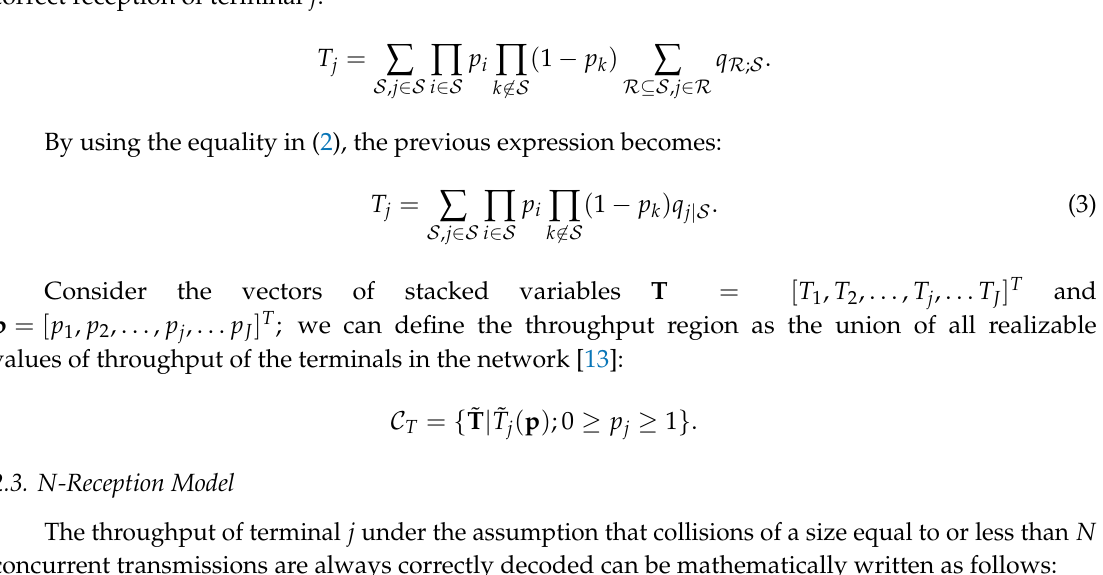
Table 1. List of main variables. Variable Meaning Total number of terminals in the network. Number of antennas at the receiver. Transmission probability of terminal j . Packet throughput of terminal j . Probability of correct reception of terminal j given the set of colliding terminals T . q S|T Probability of correct reception of all terminals in S given the set of colliding terminals T . Vector of stacked throughput variables of all terminals. C T Throughput region. Vector of stacked probability variables of all terminals. α MPR reception exponent. S |S | = l l Set of terminals of size l : l